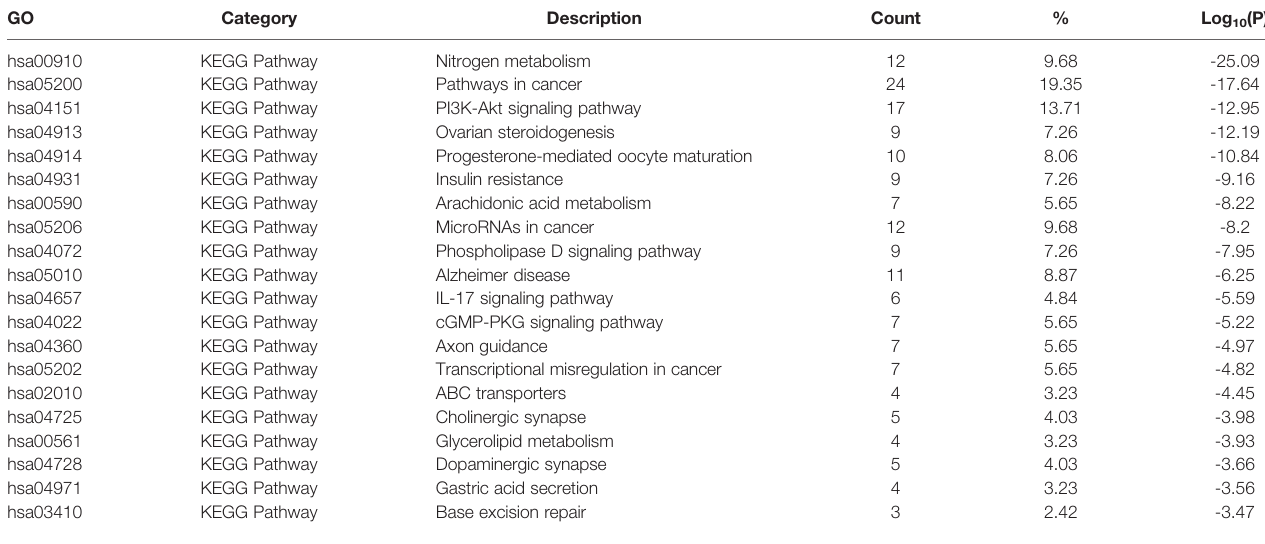
TABLE 4 | List of tops enriched KEGG